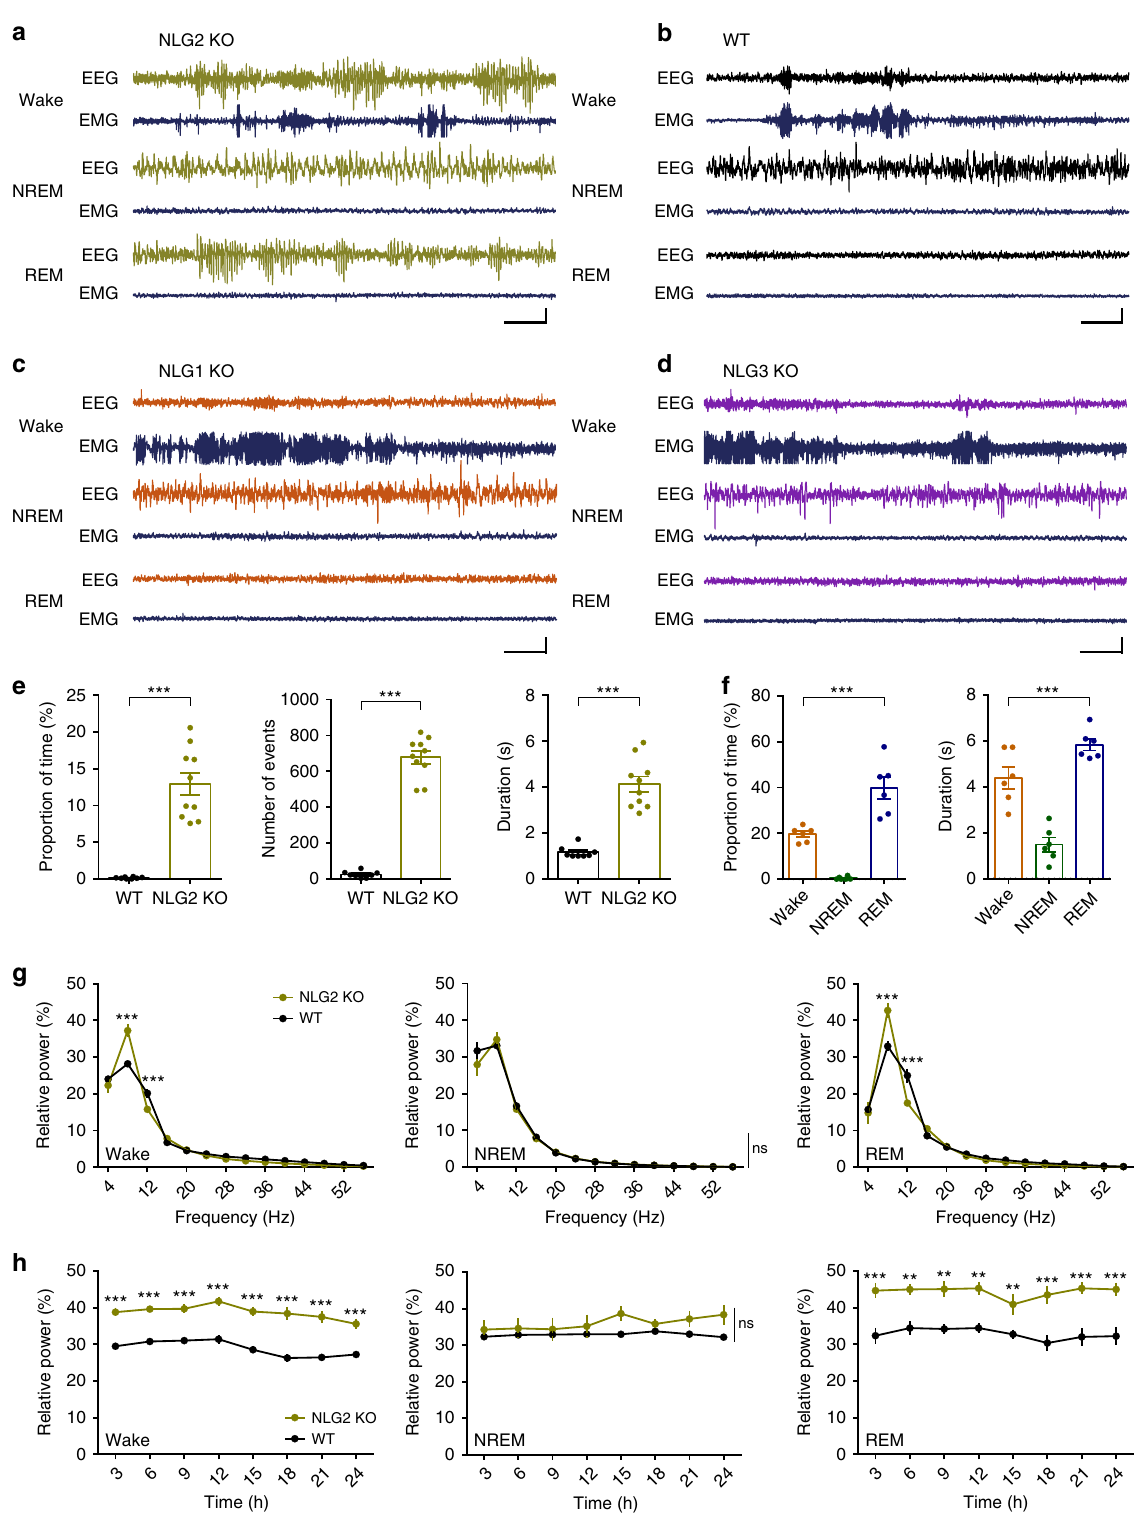
Supplementary Fig. 5a – c, Supplementary Table 1). We then compared synaptic transmission by recording spontaneous exci- tatory postsynaptic current (sEPSC), spontaneous inhibitory postsynaptic current (sIPSC), and miniature inhibitory post- synaptic current (mIPSC). We found no differences between genotypes in sEPSC, sIPSC, or mIPSC in either nRT (Fig. 3e – g, i – k; Supplementary Fig. 4d – f) or cortical (Supplementary